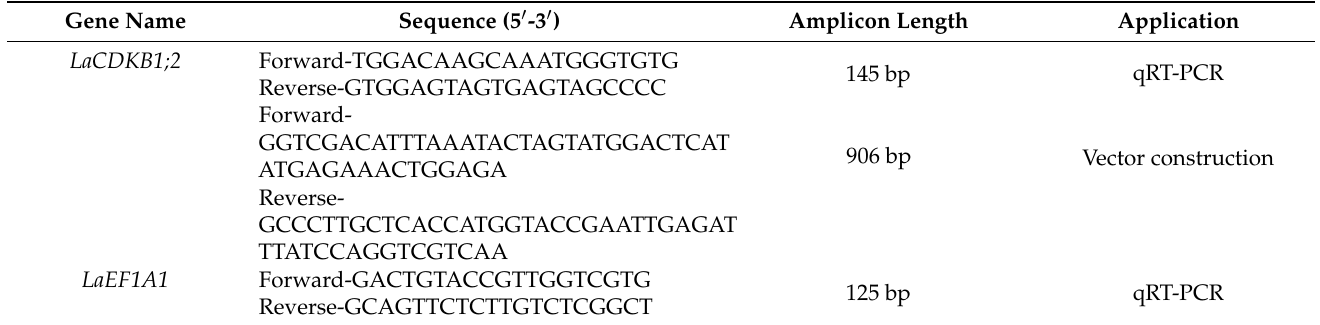
Table 1. Primers used in the